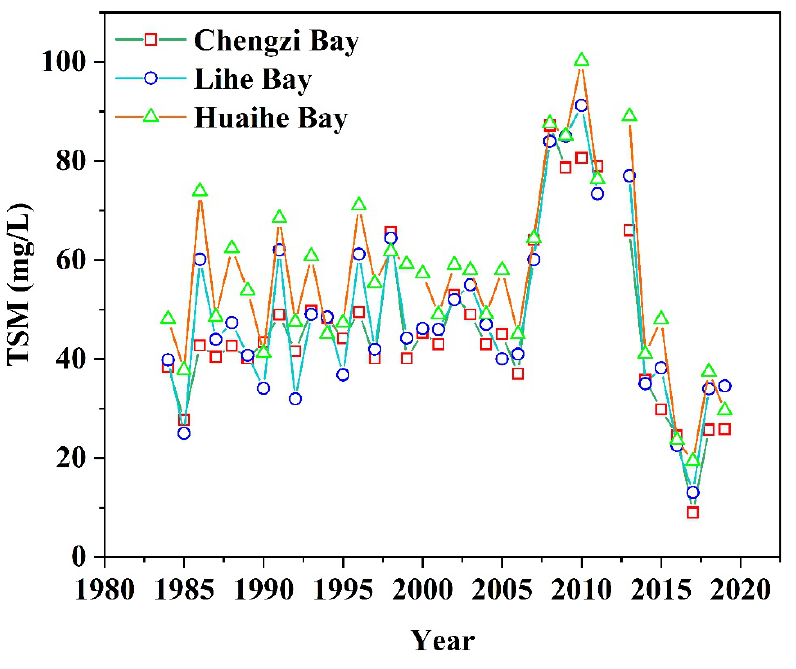
Figure 7. Line chart of TSM changes in the Chengzi Bay, Suhe Bay, and Huaihe Bay from 1984 to 2019.